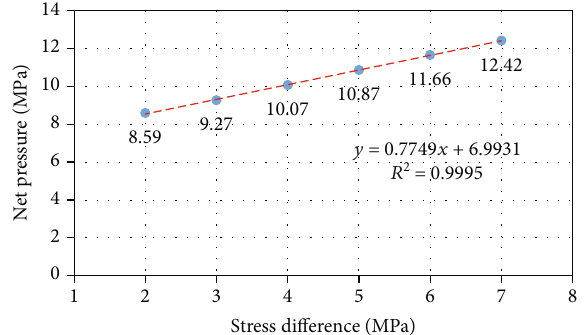
Figure 17: The relationship between required net pressure and stress di ff